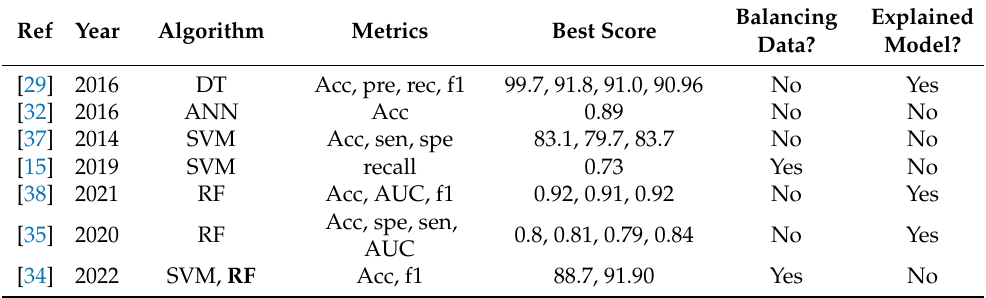
Table 1. Summary of papers using ML for bank churn prediction. The best models are in bold. Ref Year Algorithm Metrics Best Score